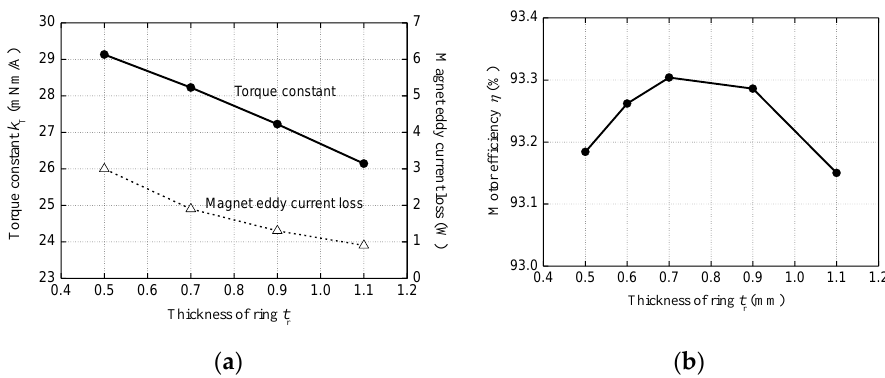
Figure 12. Effect of changing ring thickness ( N = 30,000 rpm, P o = 500 W): ( a ) torque constant and magnet eddy current loss and ( b ) motor efficiency.